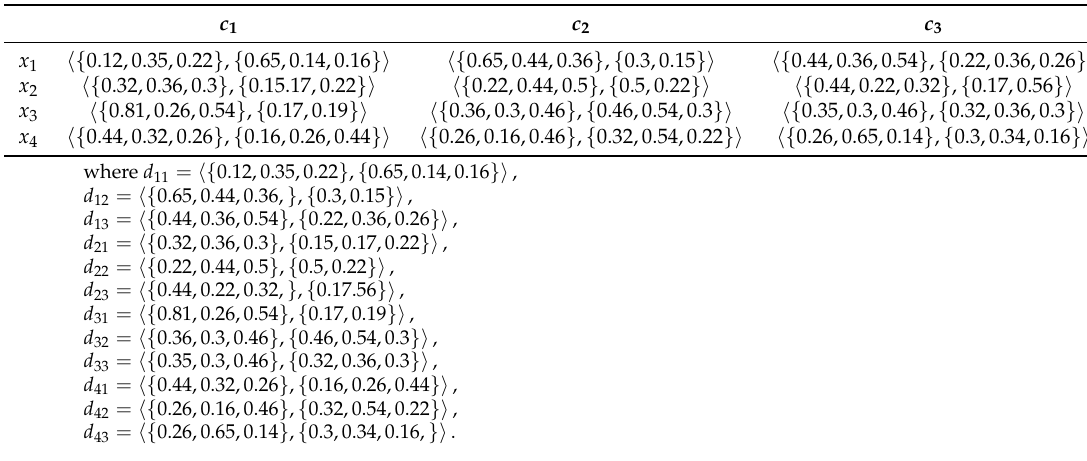
Table 7. The overall evaluation matrix R